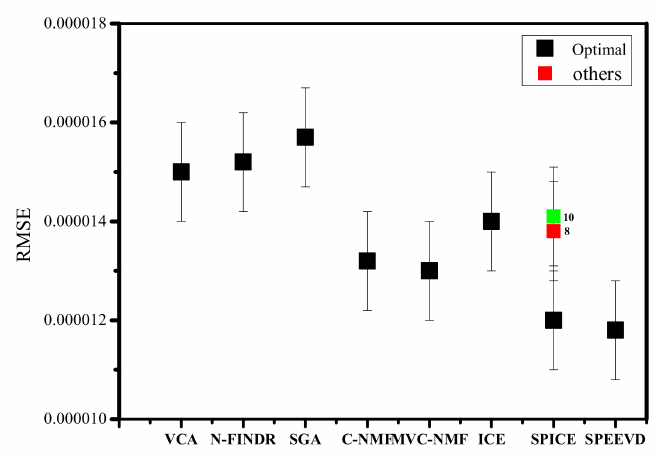
Figure 8. The RMSE of unmixing.